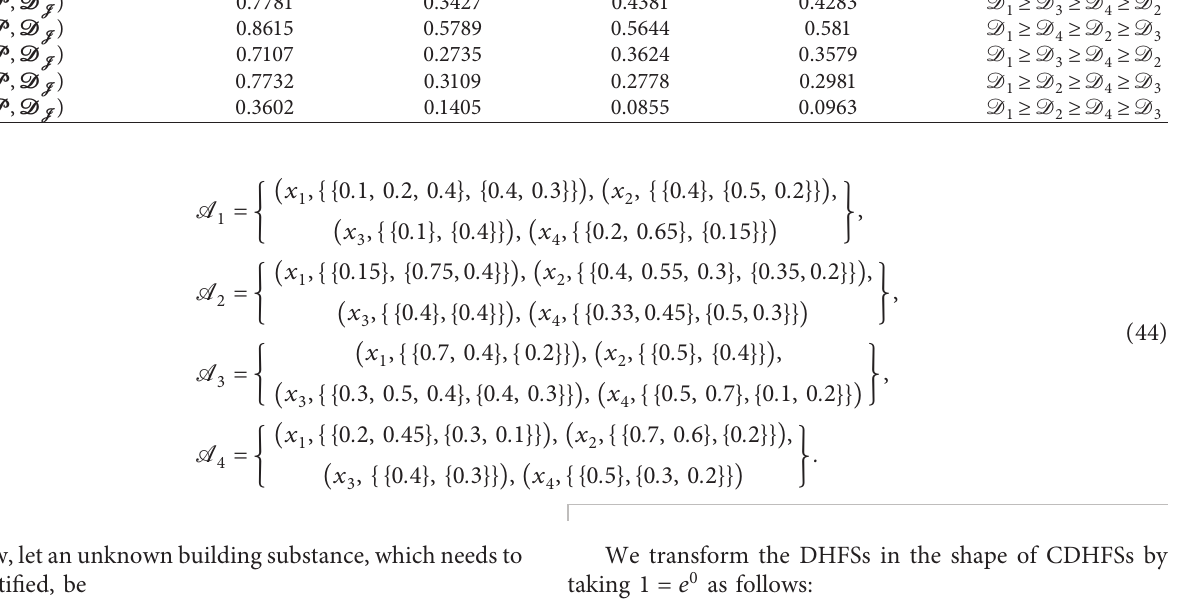
Table 4: Calculation of explored WSMs based on λ � 1 and ( η